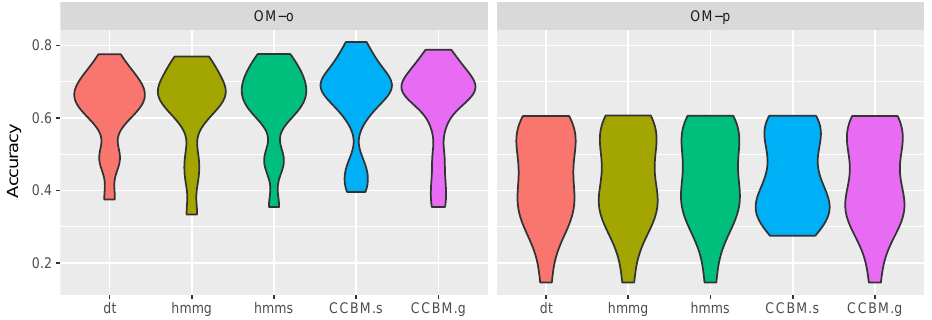
Figure 11. Activity Recognition results. OM-o refers to the optimistic observation model, OM-p to the pessimistic observation model, dt is decision tree, hmmg is the general HMM, hmms is the specialised HMM, CCBM.s is the specialised CCBM, and CCBM.g is the general CCBM.